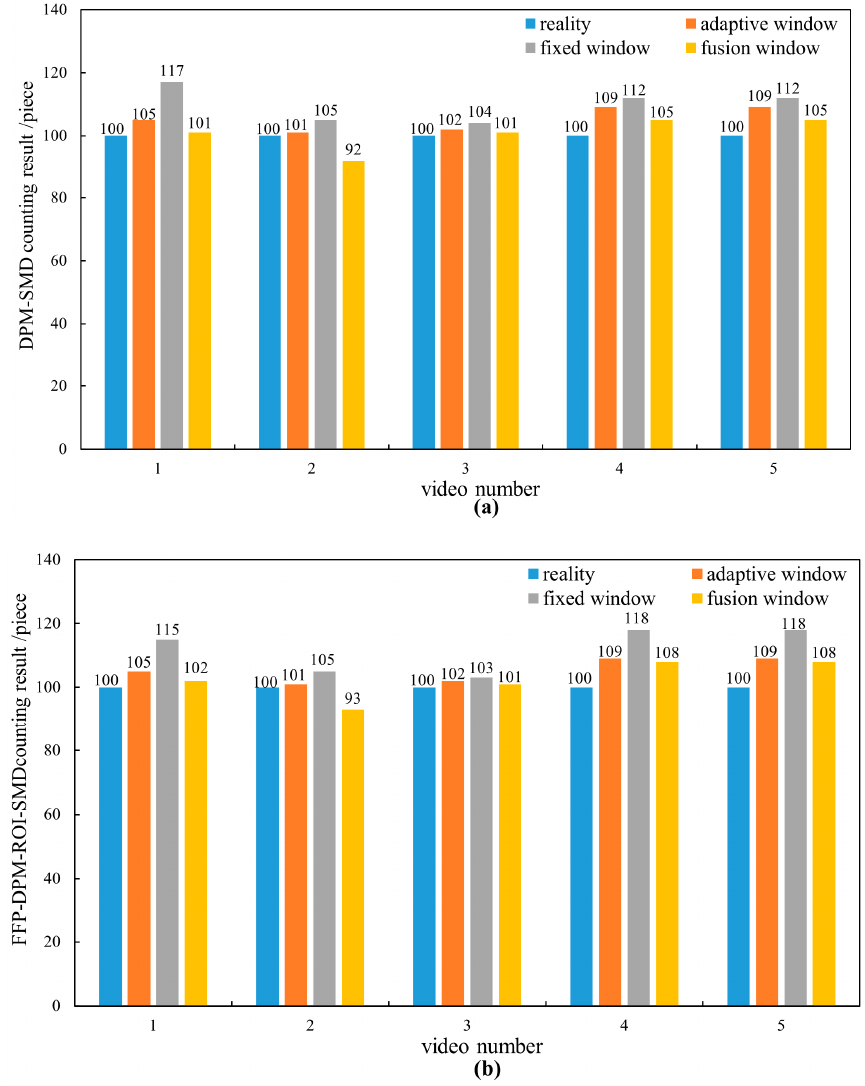
Figure 13. Counting results of different algorithms for topographic maps: ( a ) DPM–SMD method counting result; ( b ) FFP–DPM–ROI–SMD method counting result. Blue represents the actual number of maps in the videos, orange represents the counting result of the adaptive window, gray represents the counting result of the fixed window, and yellow represents the counting result of the fusion window counting algorithm. Table 3. Comparison of counting accuracies of different algorithms.